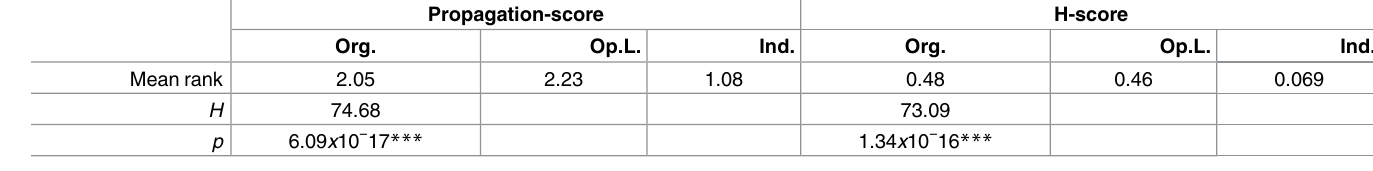
Table 1. Comparison of influential values in breadth ( propagation-score ), and depth ( hop-score ). Results from Kruskal-Wallis Test